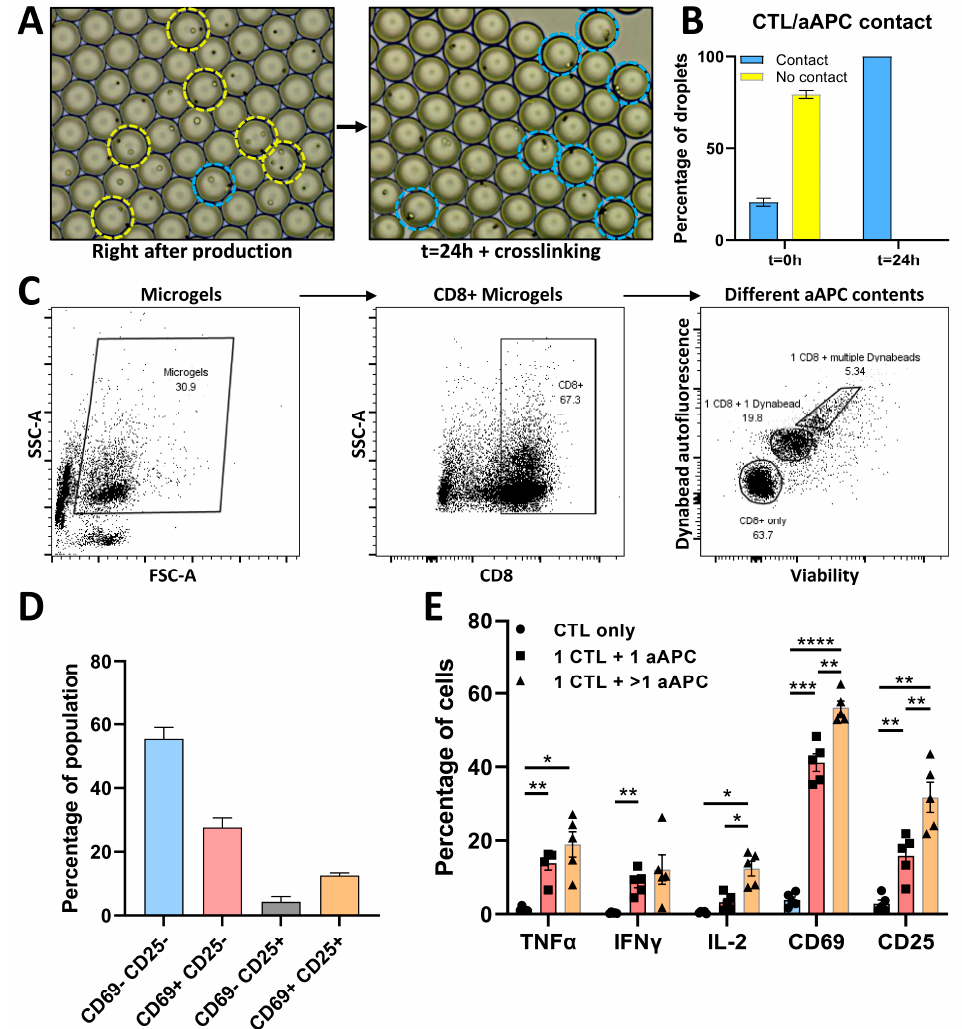
Figure 4. Encapsulation and flow cytometric measurement of CTL/aAPC pairs in microgels. ( A ) Brightfield microscopy images of droplets for CTL/aAPC pairing; Left image displays droplets di- rectly after production at 37 °C where cells and particles are free floating in agarose solution drop- lets, right image displays droplets after 24h of incubation at 37 °C and subsequent gelation at >18 °C where cells are fixed in crosslinked agarose. Yellow circles indicate CTL/aAPC combinations where no contact is observed, blue circles indicate combinations where contact is observed. ( B ) Re- sults of manual quantification of n = 46 images containing n = 532 CTL/aAPC paired droplets from n = 3 independent experiments. error bars represent n = 3 experiments. ( C ) Gating strategy of CTL/aAPC droplets; all non-empty microgels are selected, all microgels containing at least a CD8+ cell are gated, based on Dynabead autofluorescence and viability dye intensity gates are drawn for single viable CTLs, 1:1 pairs of CTL/aAPCs, and microgels containing a CTL and multiple aAPCs. ( D ) Prevalence of populations of 1:1 aAPC activated CTLs based on CD25 and CD69 expression. Data represent SEM of n = 5 biological replicates. ( E ) Data summary of activation markers in micro- gels containing only CTLs (blue), microgels containing 1 CTL and 1 aAPC (red), and microgels con- taining 1 CTL with multiple aAPCs (orange). Data show n = 5 biological replicates with SEM. * p < 0.05, ** p < 0.01, *** p < 0.001, **** p < 0.0001, if no significance is indicated none was found.